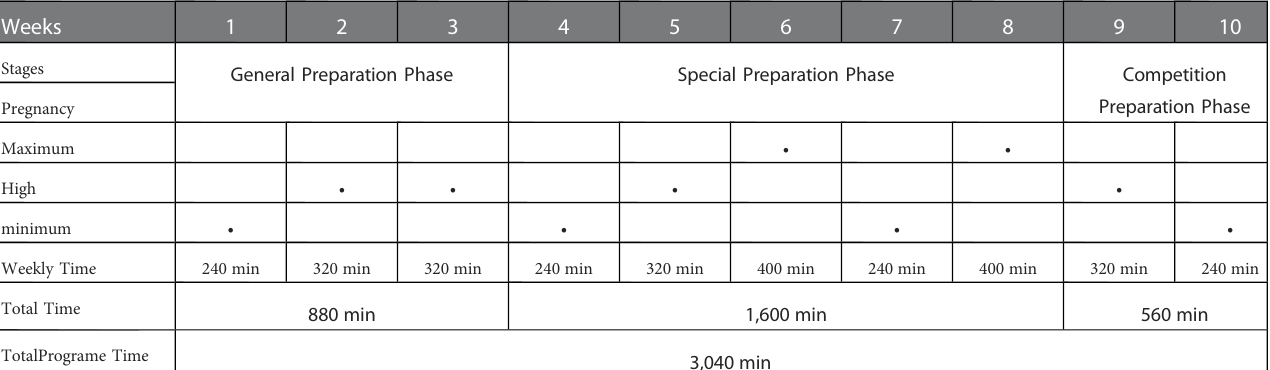
TABLE 1 The content, techniques used in the sports